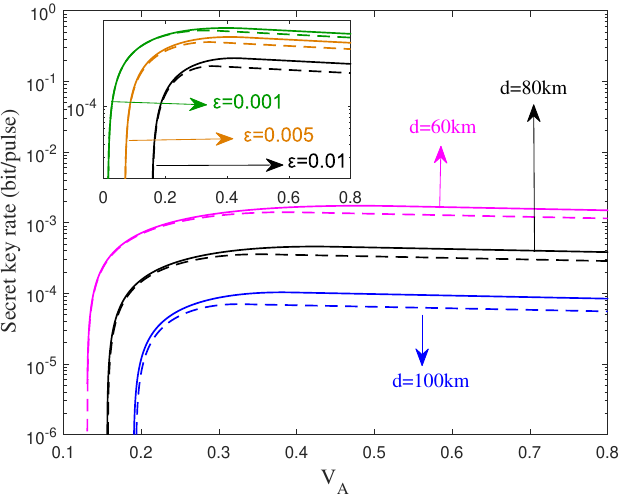
Figure 5. Asymptotic secret key rate of the CVQKD system with the ZPC-based DM source preparation for ε = 0.01, where solid lines denote the eight-state DM source preparation, while dashed lines represent the four-state DM source preparation. The inserted subgraph shows that asymptotic secret key rate of the CVQKD system for L = 80 km.